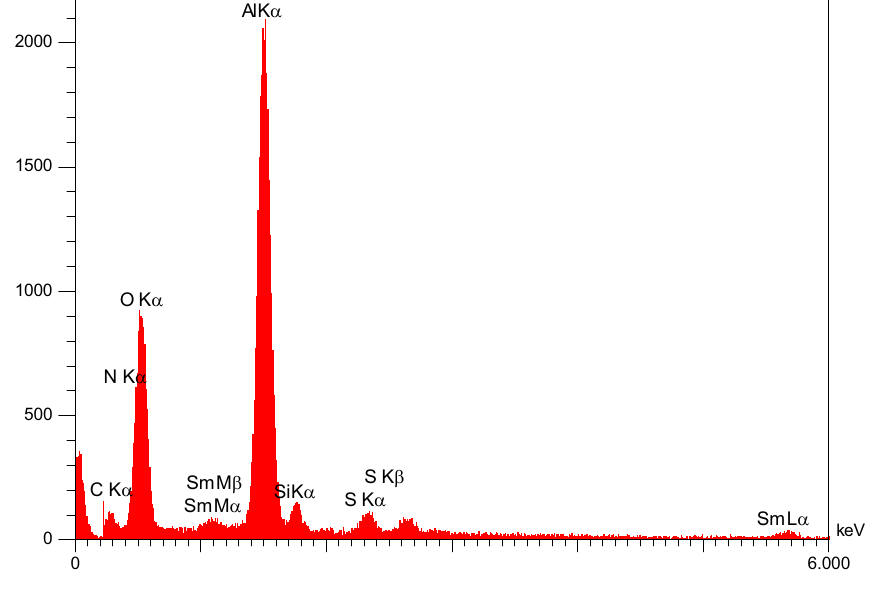
Figure 4. EDS diagram of Sm-bis(PYT)@boehmite.